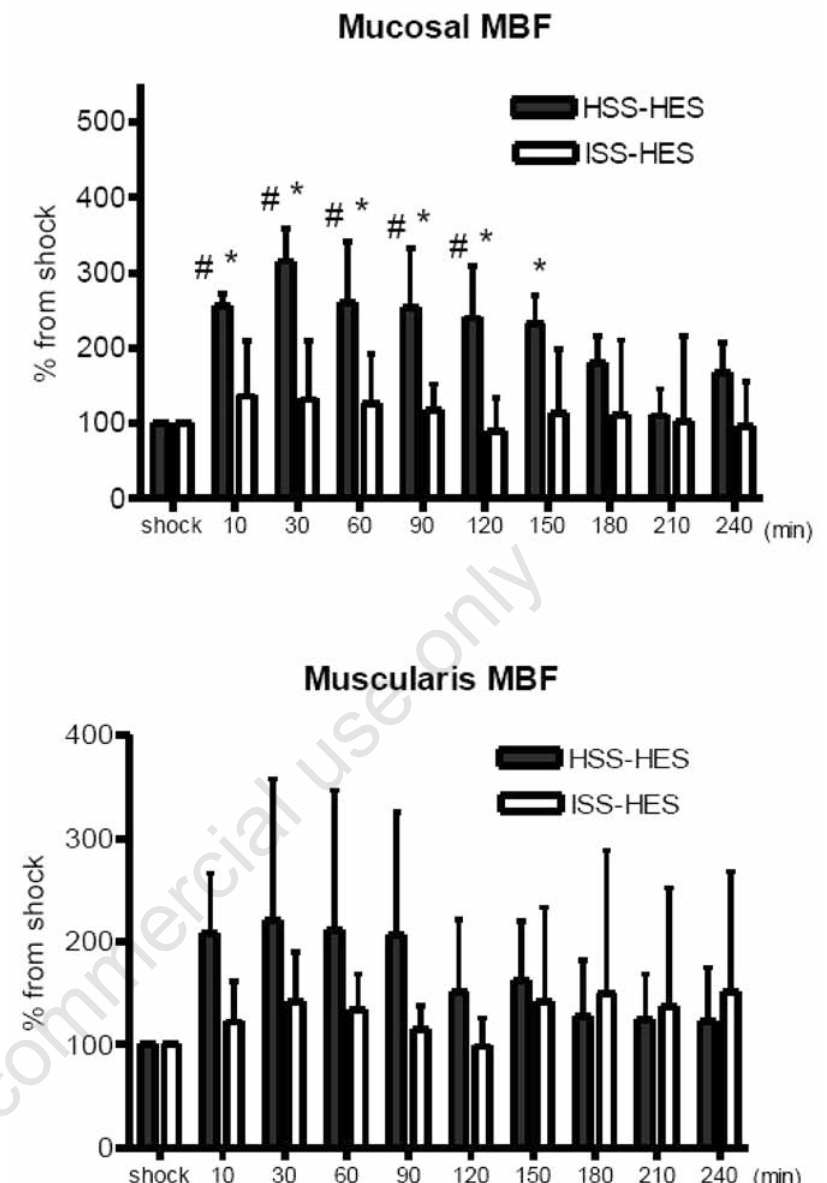
Figure 4. Relative ileal mucosal and muscularis microcirculatory blood flow changes dur- ing fluid administration after the onset of septic shock. Pigs were resuscitated with either hypertonic saline 7.2%/ hydroxyethyl starch (HSS-HES) or isotonic saline 0.9%/hydrox- yethyl starch (ISS-HES). All microcirculatory blood flows (MBF) were set at 100% before fluid administration at T shock and measured values were expressed as percentage of T shock. Data are presented as mean±SD. * P <0.05 significant difference from T shock; # P <0.05 significant difference between